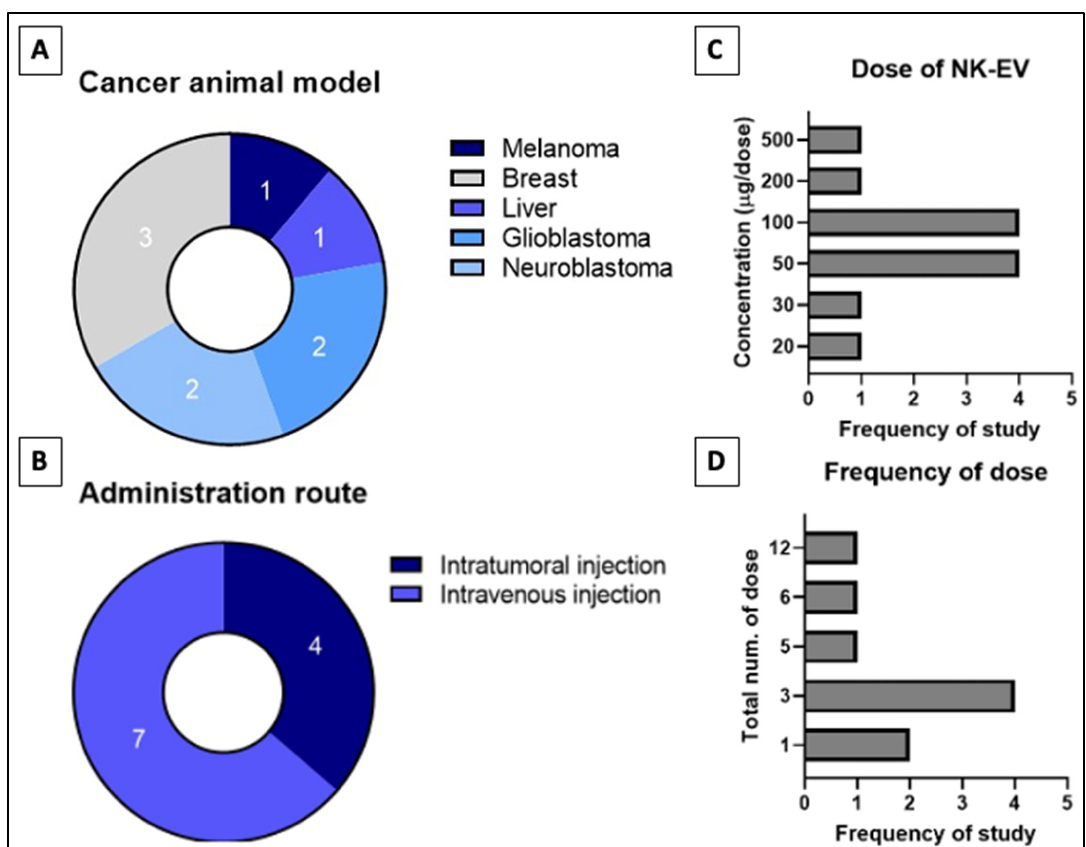
Figure 4. Distribution of in-vivo studies for ( A ) type of cancer studied, ( B ) administration route of NK-EVs, ( C ) tested dose of NK-EVs per dose and the ( D ) frequency of dose administered throughout study phase. Numbers indicated in ( A , B ) refers to the frequency of reviewed studies that fall into the categories.